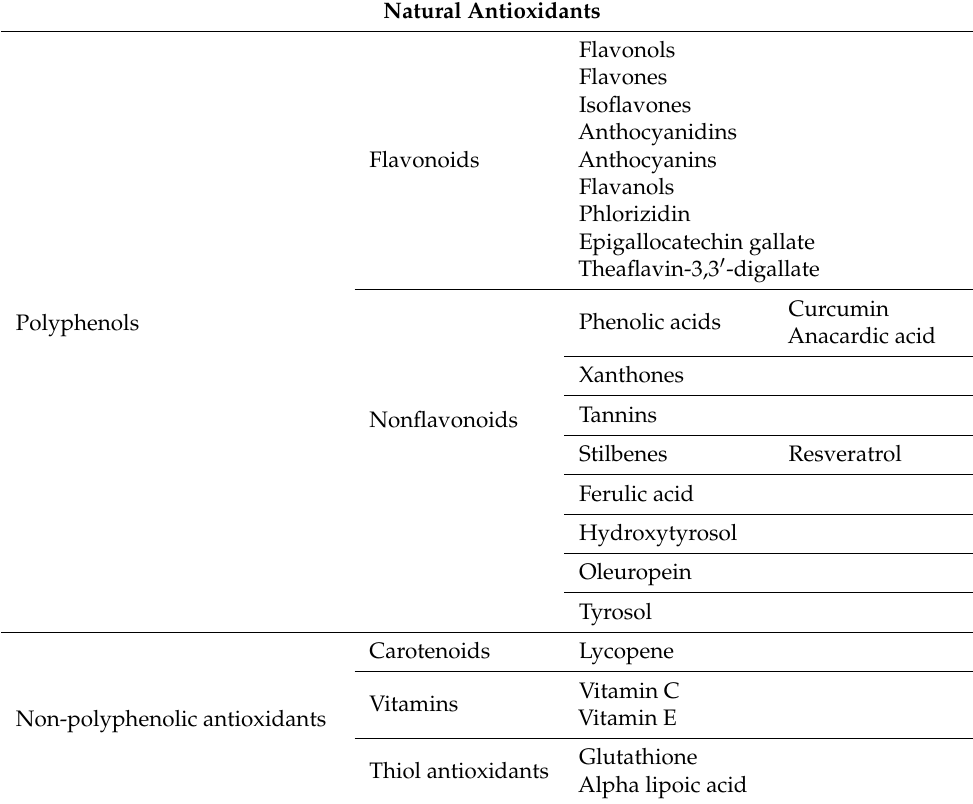
Table 1. Natural antioxidants that may play a role in bone metabolism